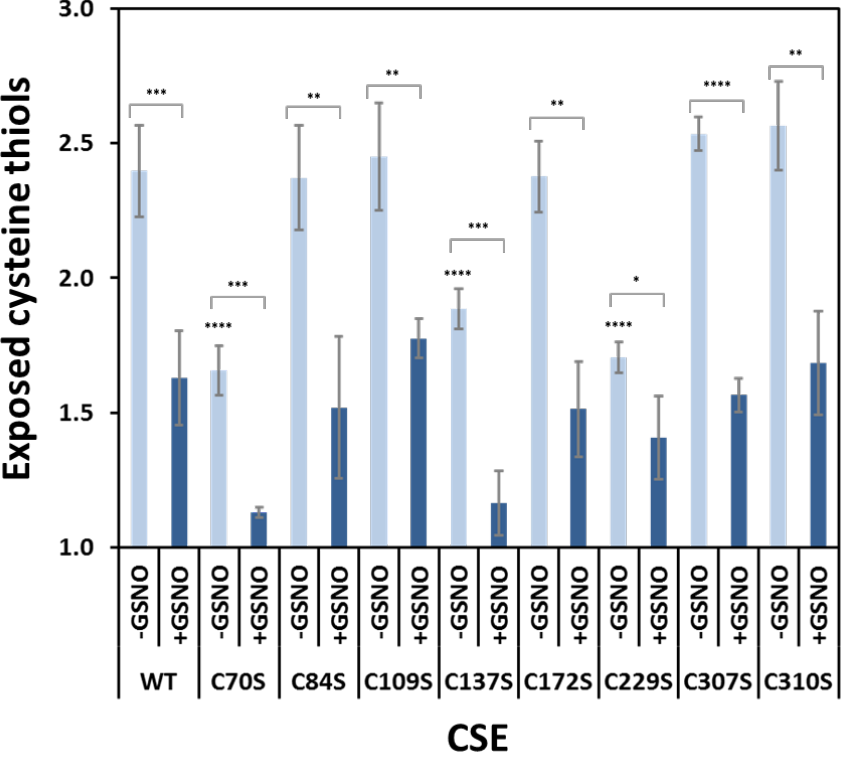
Figure 6. Number of free exposed cysteines as determined using DTNB in WT and mutated CSE for the as isolated protein (-GSNO) and upon incubation with GSNO (+GSNO). Error bars represent the standard error (SE), where n ≥ 4. One-way ANOVA was performed to check if there were differences between WT (control) versus the different variants, **** p < 0.0001. Student’s t -test was used to compare each variant with or without GSNO incubation, **** p < 0.0001, *** p < 0.001, ** p < 0.01, * p < 0.05.